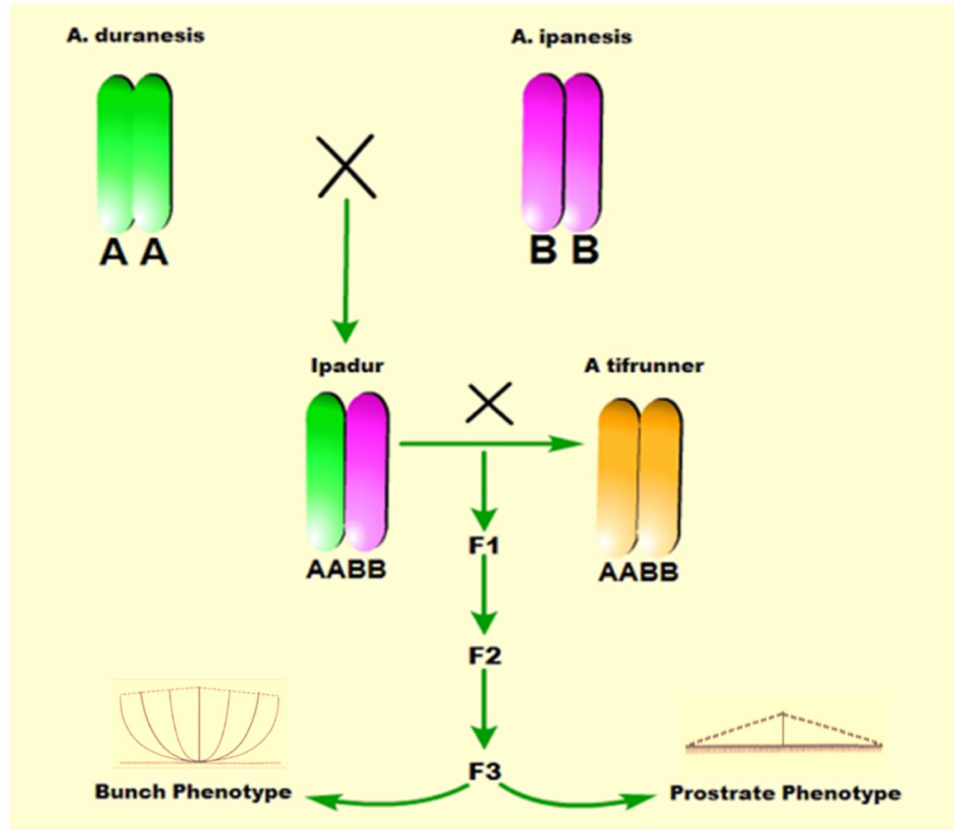
Figure 1. The schematic diagram of generating F3 progenies of TI population obtained from the hybridization of the synthetic tetraploid ‘Ipadur’ (male parent) and tetraploid cultivar A. hypogea , variety Tifrunner (female parent). The synthetic tetraploid parent ‘Ipadur’ demonstrated prostrate habit contrasting with tifrunner’ which showed bunch habit, whereas their F3 lines in T1 population developed both prostrate and bunch